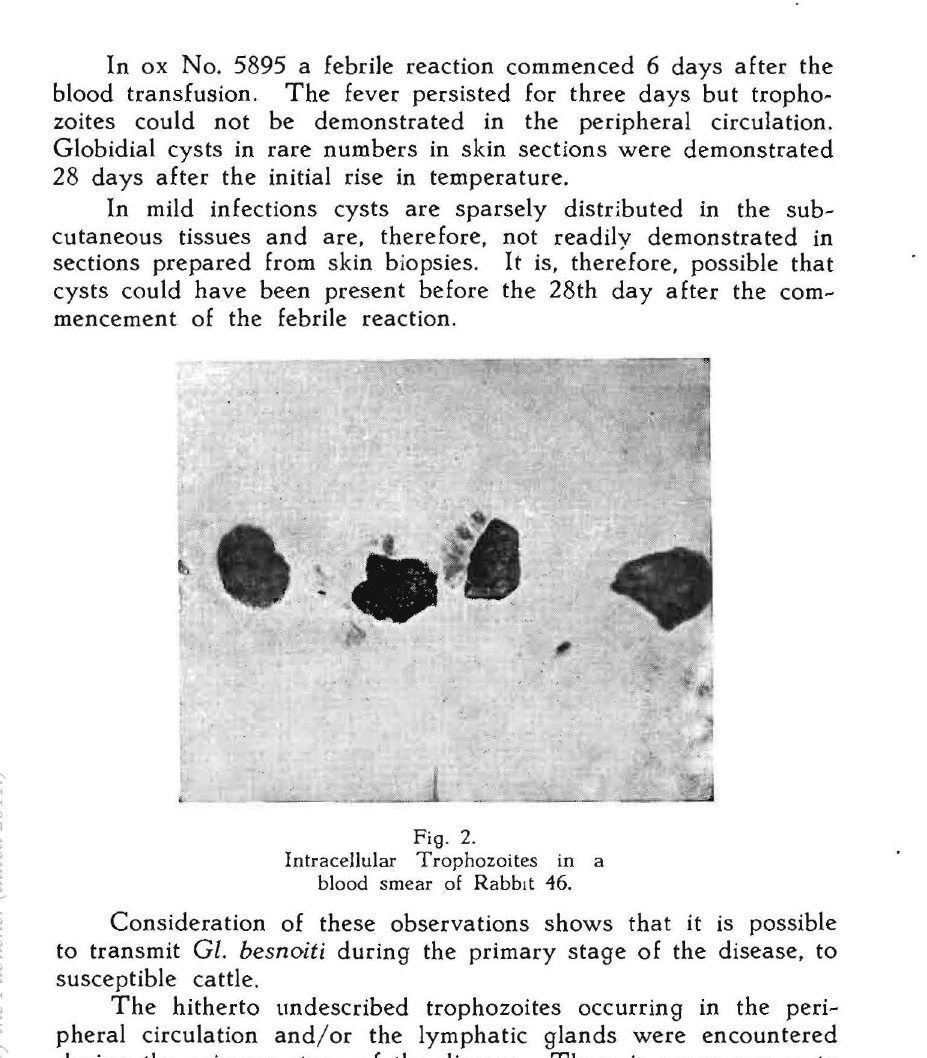
Fig. 2. Intracellular Trophozoites in a blood smear of Rabbit